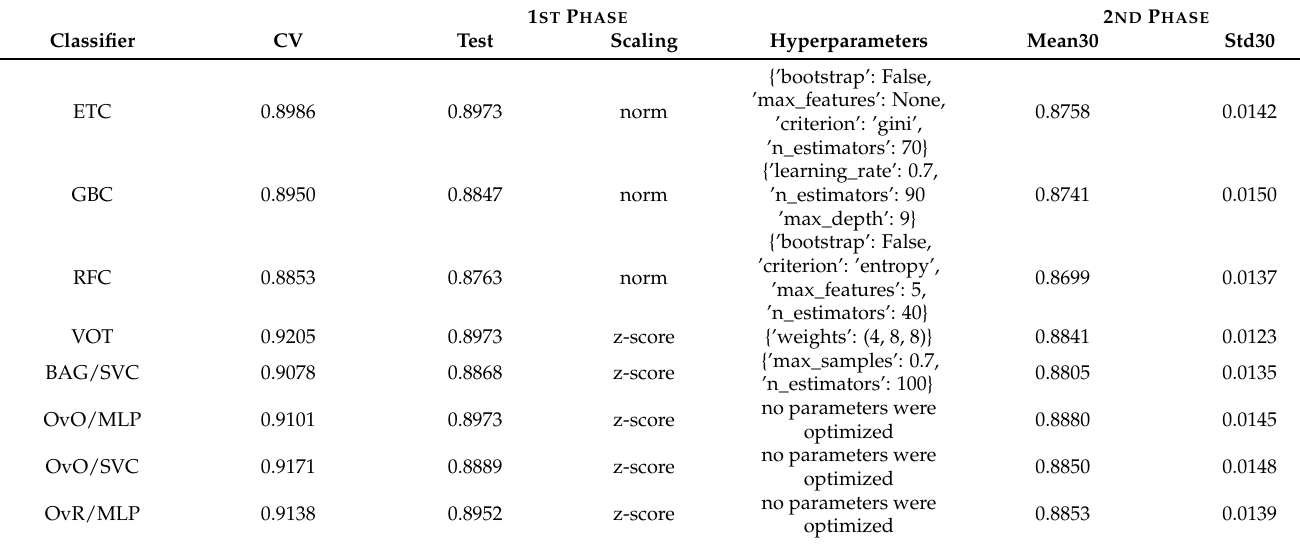
Table 6. Accuracy of the optimized ensemble classifiers (1st phase) and the results of their validation (2nd phase). The results are too similar to each other to determine a best result, so no model was chosen. The scaling procedures are denoted as follows: z - score for standardization and norm for